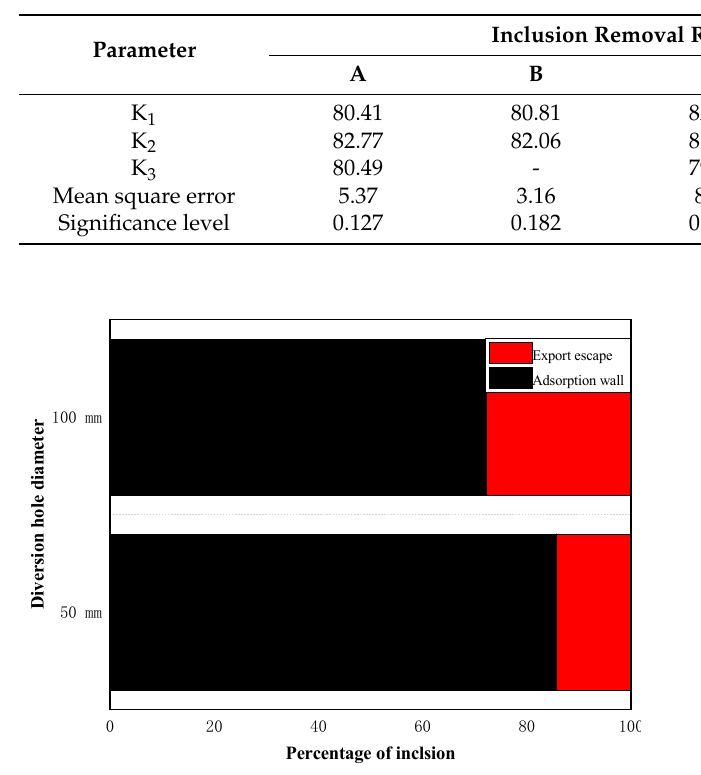
Figure 13. Bar graph of inclusion removal rate of different retaining wall opening diameters.